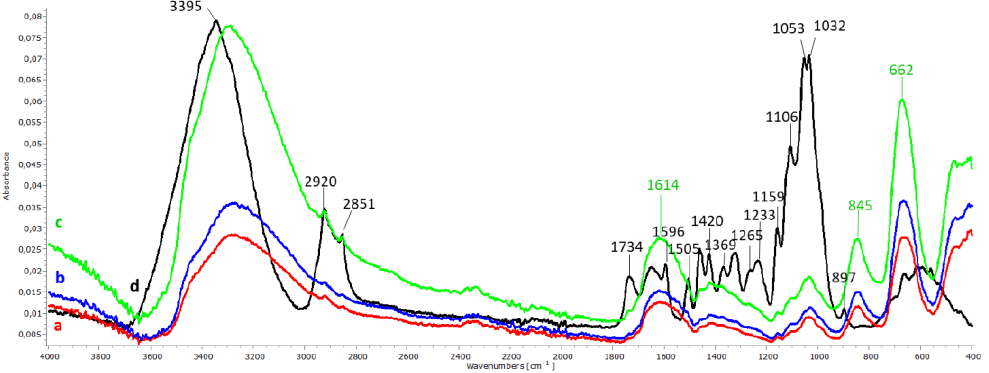
Figure 6. ATR-FTIR spectra of three stained mock-ups before DFO-B application ( a – c ) in comparison to the maple reference spectrum ( d ). Spectra were ATR- and baseline-corrected, with no further treatment.